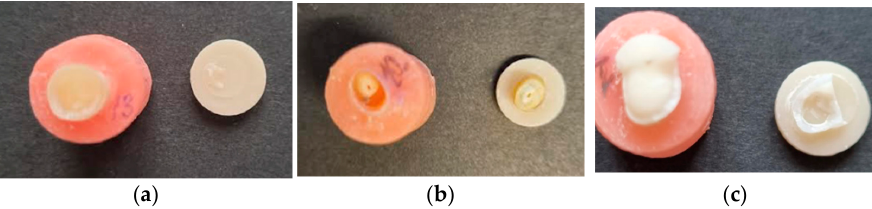
Figure 6. Different failure modes. ( a ) Adhesive fracture, overlay separated from the tooth evenly with cement on the overlay, without any visible fractures; ( b ) Cohesive fracture: the failure in ‐ cludes a total specimen fracture or ( c ) cohesive with cement present on both surfaces, overlay and tooth specimen.